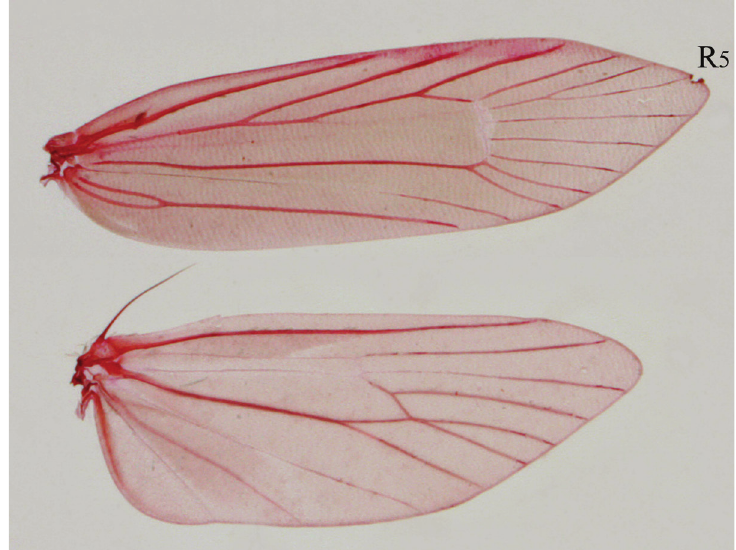
Figure 6. Wing venation of Roeslerstammia tianpingshana sp. n., male. Female genitalia (Fig. 9). Papillae anales narrow and apically pointed in ventral view, nearly triangular in lateral view. Apophysis posterioris slender, 0.7 × as long as